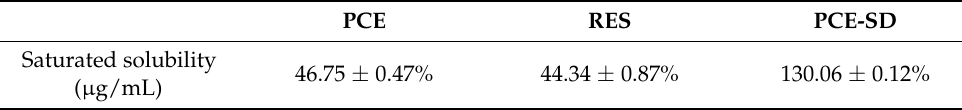
Table 3. Saturated solubility of PCE and